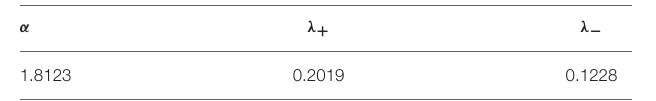
TABLE 6 | Standard CTS